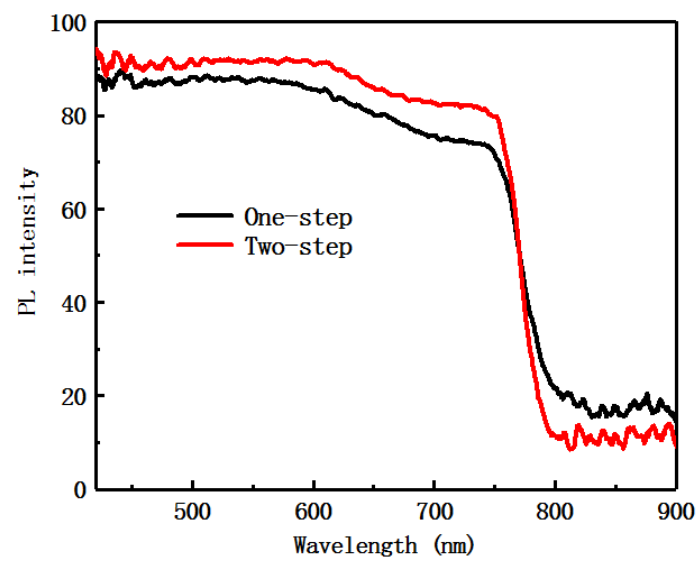
Figure 5. UV-visible absorption spectra of perovskite films with the one-step and the two-step methods.